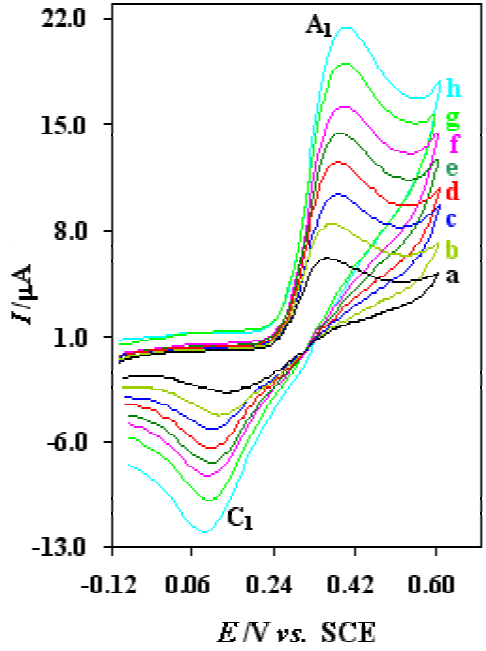
Figure 5. Typical voltammograms of 0.75 mM of thiourea at alumina modified Pt electrode (2 mm diameter) in acetate buffer solution (C = 0.15 M, pH = 4.5) at various scan rates. Scan rates from (a) to (h) are: 25, 50, 80, 120, 170, 225, 306 and 400 mV/s, respectively T = 25 – 1 o